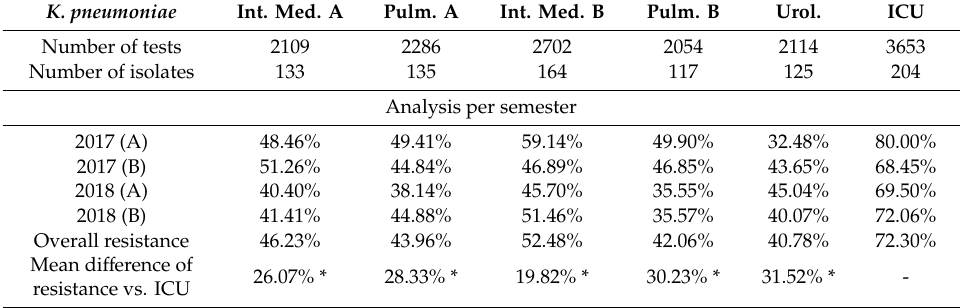
Table A7. Number of tests processed in di ff erent antibiotics, number of isolates, overall resistance per ward and semester and mean di ff erence of resistance versus ICUs regarding K. pneumoniae during the 2 years (2017–2018).